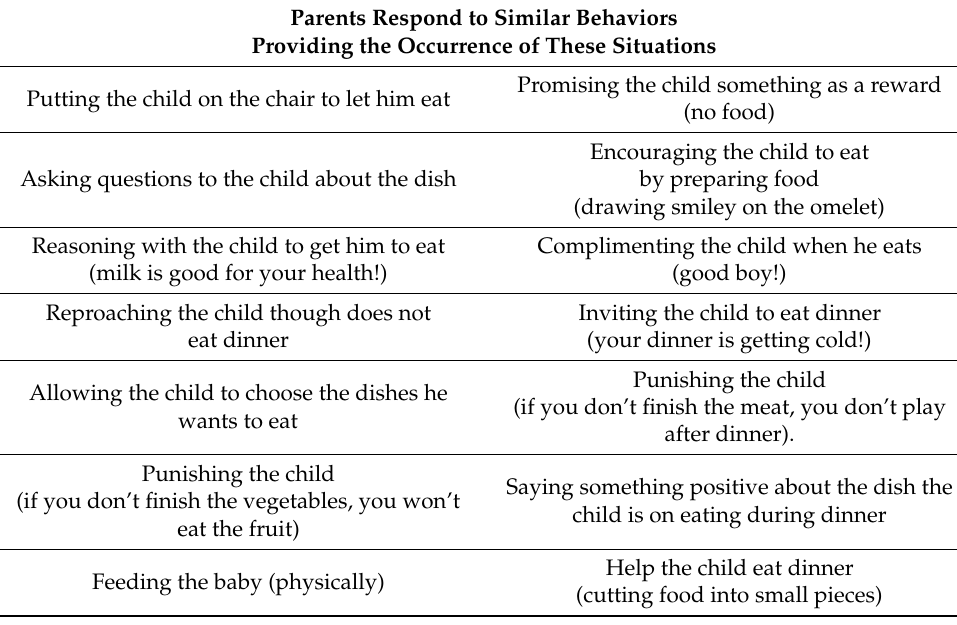
Table 2. Representative items of the educational caregiver feeding practices. Parents Respond to Similar